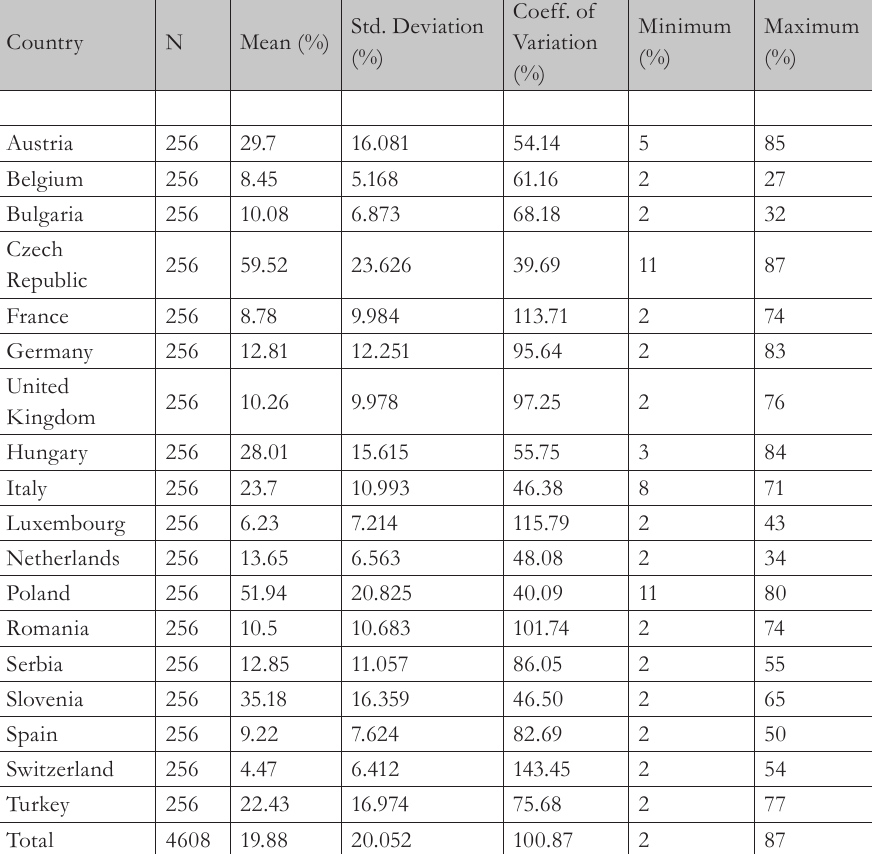
Tab. B – Characteristics of proportions of the return transportations offered from individual countries to Slovakia in (%). Source: own research Country N Mean (%)